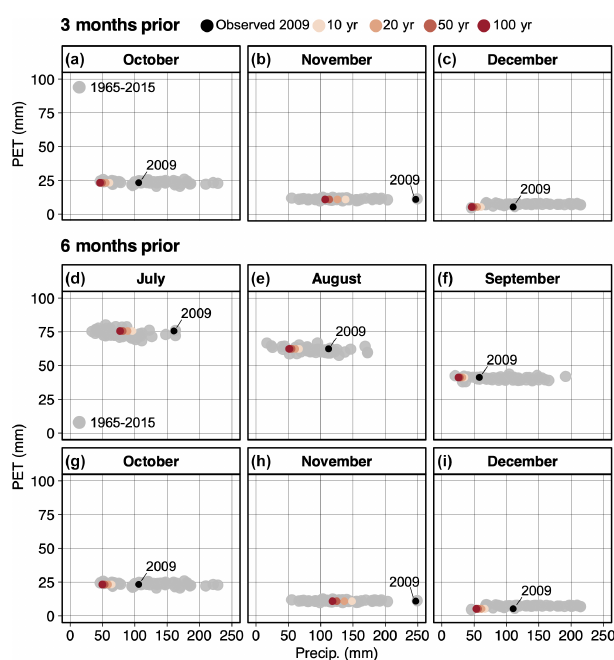
Figure 1. October to December (top) and July to December (bot- tom) monthly precipitation and PET (1965–2015) at an example catchment in southern England. The black circle indicates the ob- served value in 2009, and the coloured circles indicate the value after precipitation 3 and 6 months prior to the 2010–2012 drought is reduced at four return